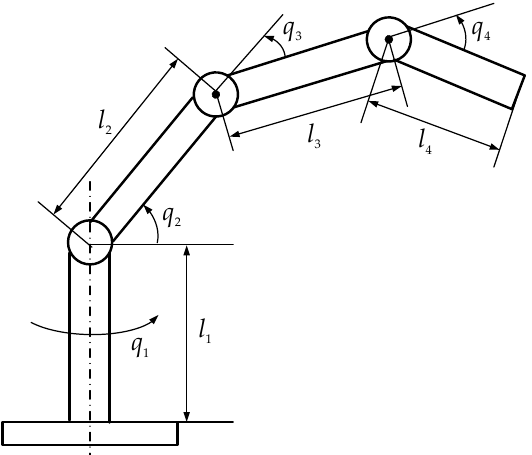
Figure 2. The robot diagram. Table 1. D-H